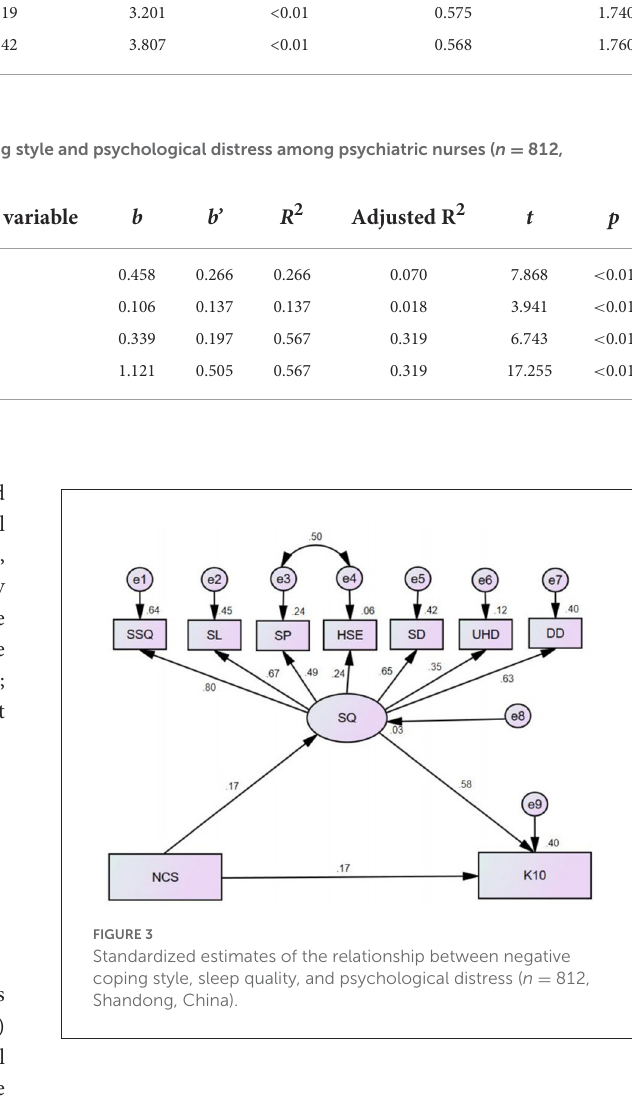
relatively negative view of the problems and choose to withdraw, disengage and refuse to communicate with others, with their emotions as the center, thus intensifying psychological pressure and leading to psychological distress. Therefore, when faced with negative events, nurses should adopt positive coping strategies, focus on the problem, choose humor and actively communicate with